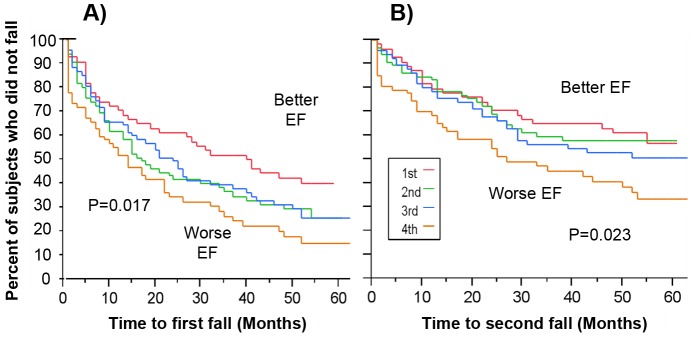
Survival curves illustrating the percent of subjects who did not fall as a function of time and executive function (EF).Differences were found in ‘time to first fall’ between the highest (indicated as 1st on the graph) and lowest EF (indicated as 4th on the graph) quartile (P = 0.017) and time to second fall (P = 0.023). Subjects with in lowest quartile were more likely to fall sooner (LEFT) and more likely to become multi-fallers sooner (RIGHT) than those in highest quartile. Note when performing similar analyses on those subjects who reported no falls in the year prior to the study, subjects with lowest quartile of EF were also more likely to fall during the follow-up period, similar to what is observed if the entire cohort is included in the analysis. EF quartile was defined based on the ranking of EF scores obtained at baseline using the computerized cognitive battery. By definition, subjects in the lowest quartile had the lowest (i.e., relatively worst) EF scores, whereas subjects in the highest quartile had the highest (i.e., best) scores.